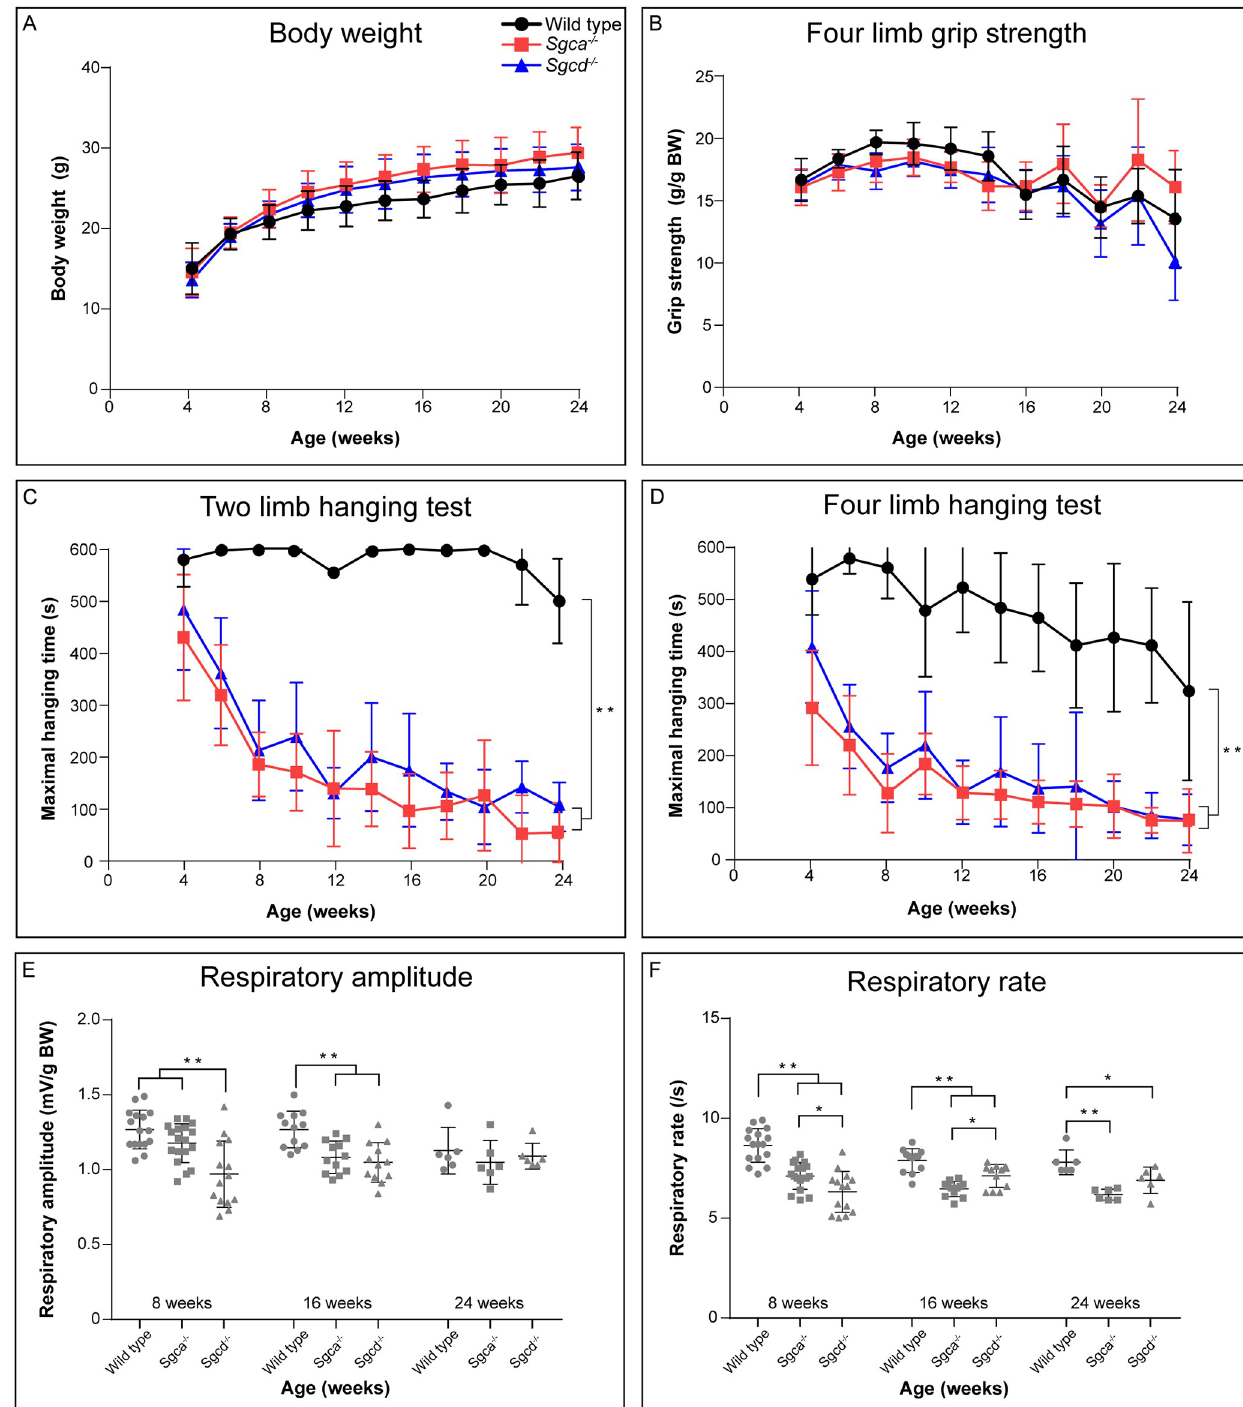
Fig 1. Functional performance and respiratory function of wild type, Sgca -/- and Sgcd -/- males. (A) Body weight. (B) Four limb grip strength normalised for body weight. (C) Maximal two limb hanging times. (D) Maximal four limb hanging times. (E) Respiratory amplitude corrected for body weight. (F) Respiratory rate. N = 6–18 male mice per group. Values are presented as mean ± SD. � p < 0.05, �� p < 0.01.